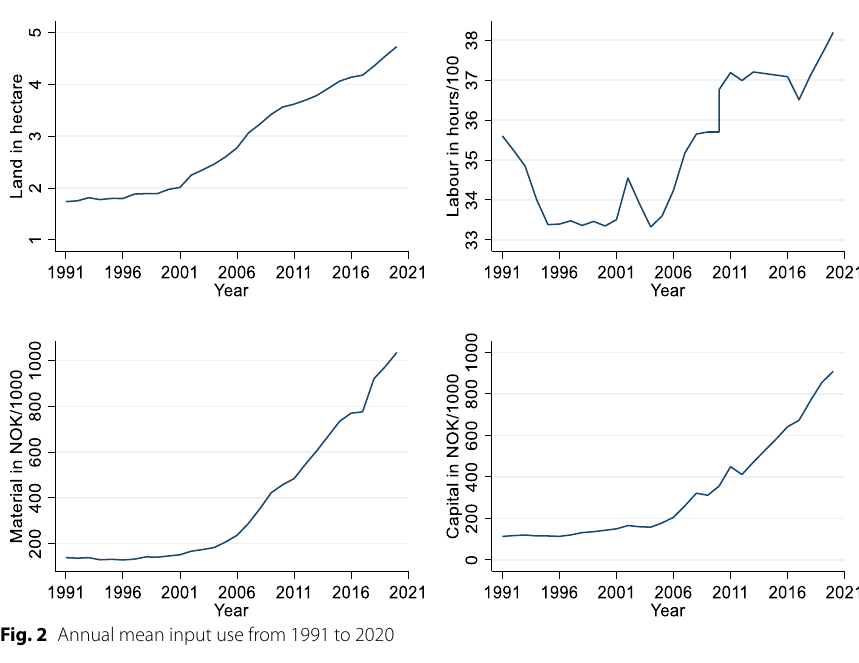
Fig. 2 Annual mean input use from 1991 to 2020